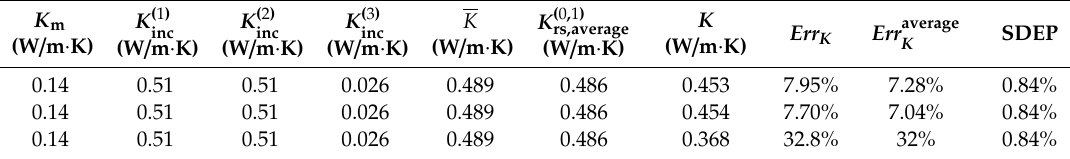
Table 3. The numerical results for the equivalent thermal conductivity of the PBX 9501.